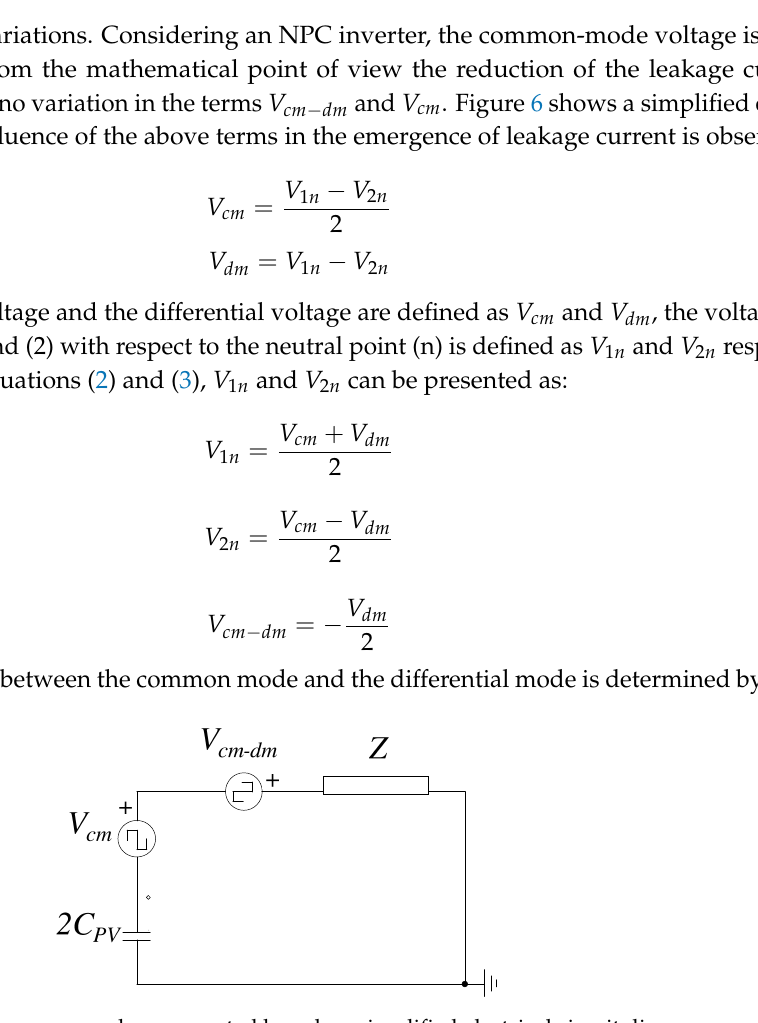
Figure 6. Common-mode represented based on simplified electrical circuit